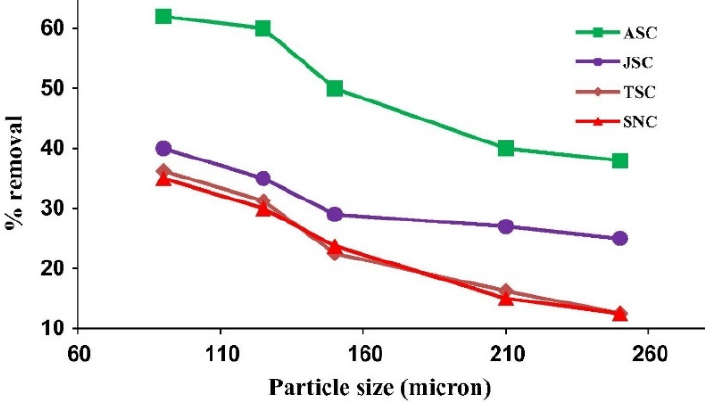
Figure 6. Representation of particle size trends, where the used adsorbents are ASC—aamla seed carbon, JSC—jambul seed carbon, TSC—tamarind seed carbon, and SNC—soapnut carbon [213].